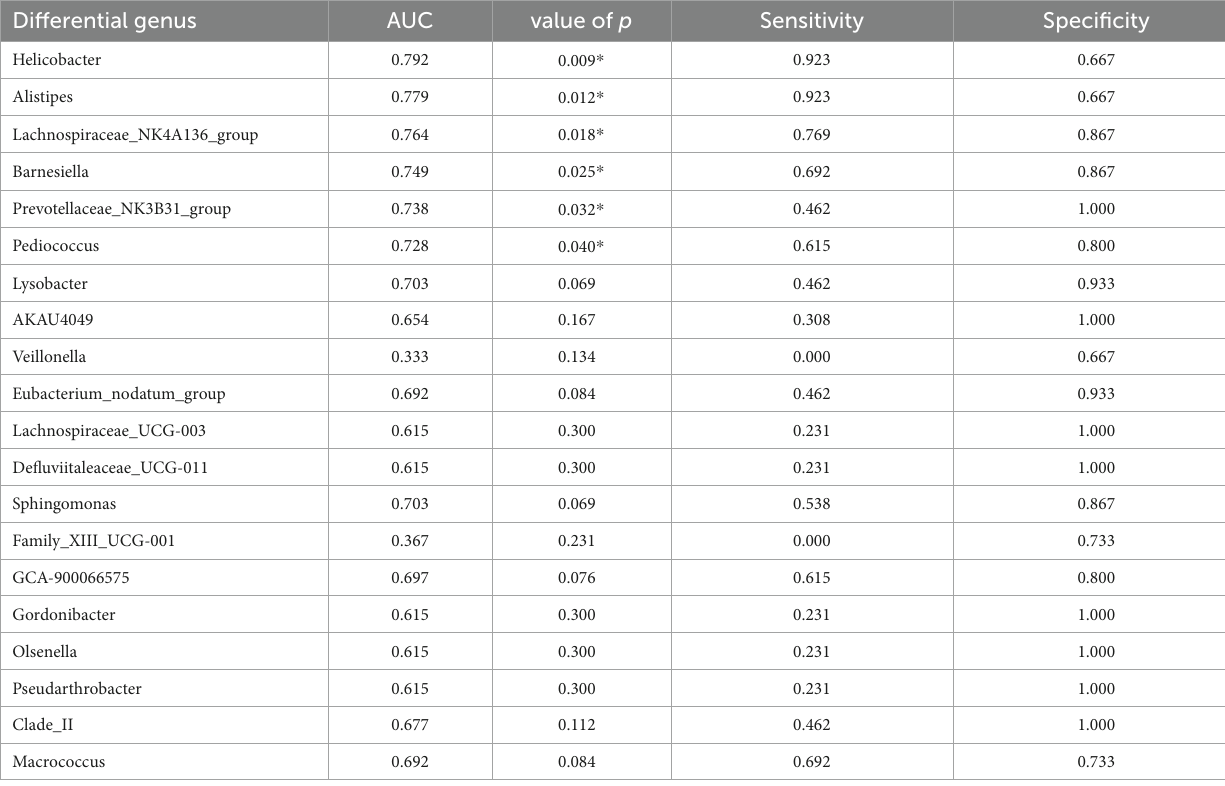
TABLE 4 ROC curve analysis of evaluation of gut bacteria for diagnosis of POCD.